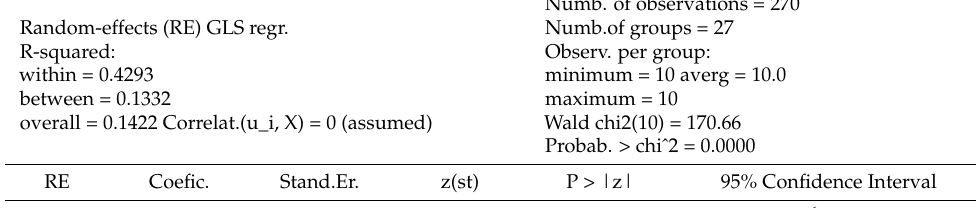
Numb. of observations = 270 Numb.of groups = 27 Observ. per group: minimum = 10 averg = 10.0